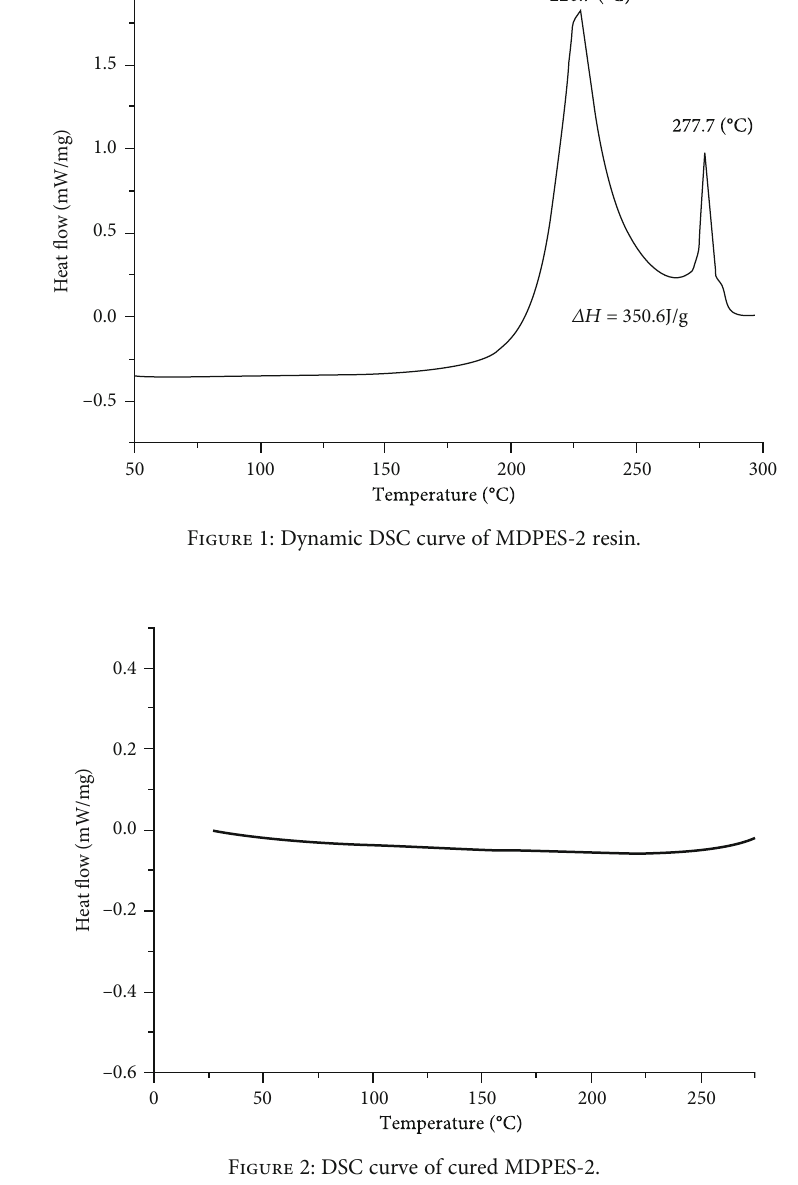
Figure 1. From the curve, it can be observed that the initial temperature ( T i ), peak temperature ( T p ), and fi nal tempera- ture ( T f ) of MDPES-2 resin curing reaction were 195 ° C, 227 ° C and 278 ° C, 290 ° C, respectively, and the heat release was 351 J/g. Heat induces free radical polymerization, hydro- silylation of Si-H and C ≡ C, and Diels-Alder reaction between C ≡ C will happen in the process of heating up of MDPES-2 resin. As a result, two exothermic peaks occurred during the whole process of curing reaction, and highly crosslinked cured products were formed.